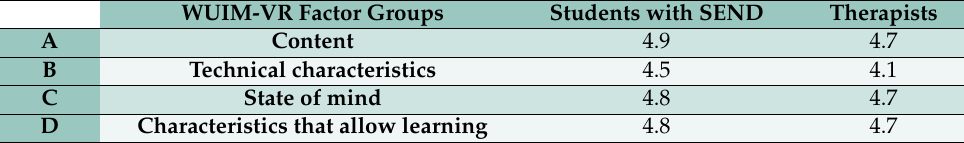
Table 5. Results of WUIM-VR user-based and content expert-based evaluation.